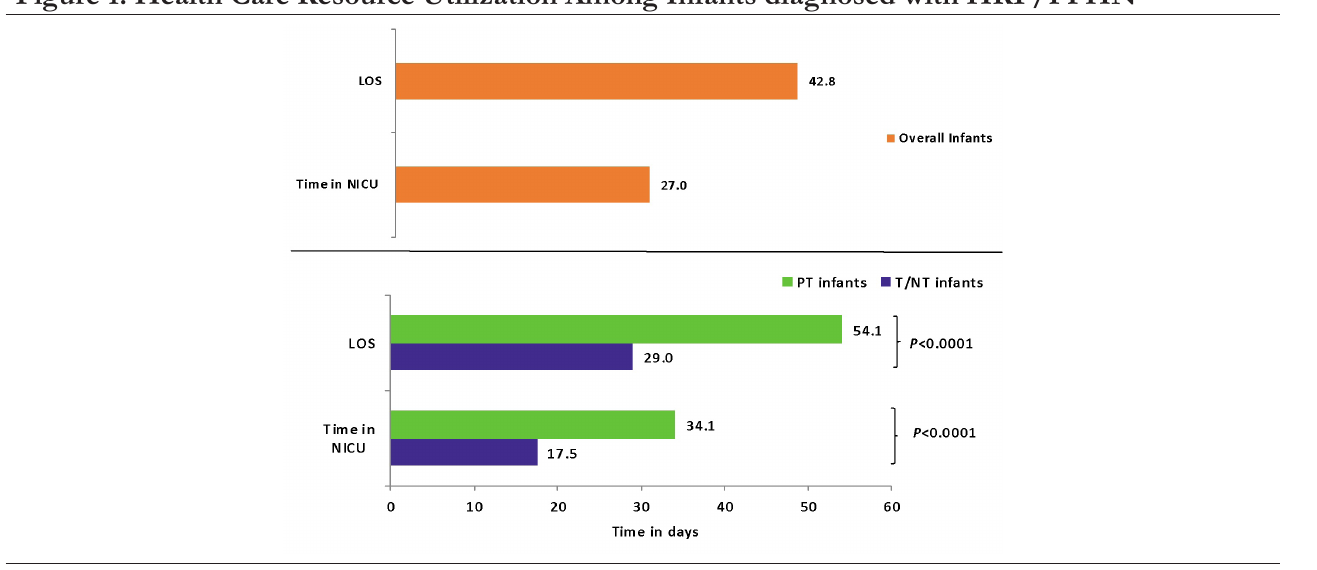
LOS: length of stay; NICU: neonatal intensive care unit; T/NT: term/near term; PT: pre-term